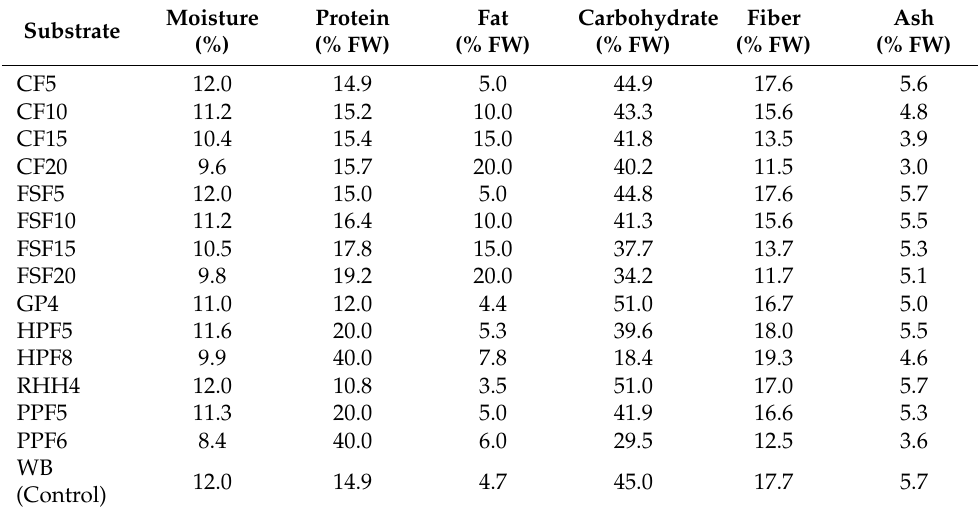
Table 2. Nutritional composition of the substrates on a fresh weight (FW) basis (%) used for Tene- brio molitor